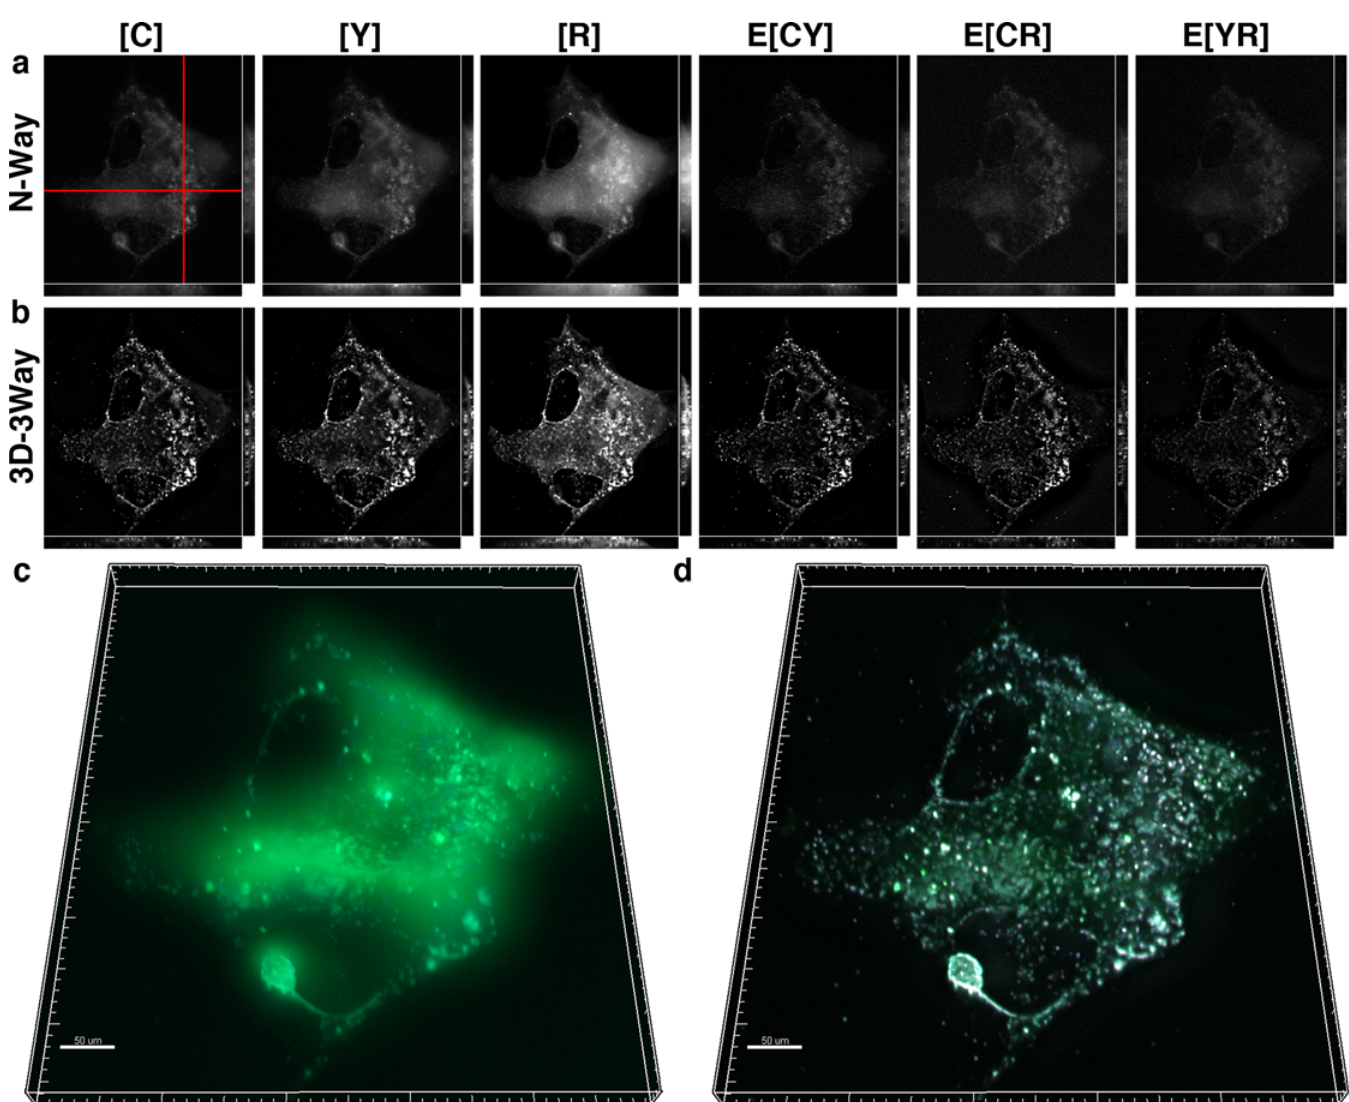
Fig 5. 3D-3Way FRET provides improved estimates for the concentration and localization of HIV-Gag oligomerization in fixed cells. Cos7 cells expressing CFP-Gag, YFP-Gag, and RFP-Gag were fixed and imaged 30 hrs post transfection. The oligomerization of Gag into punctate structures can be seen by direct application of N-Way FRET (a). Following 20 iterations of 3D-3Way FRET (b) the FRET complexes are largely restricted to the puncta and the axial resolution is greatly improved. 3D composite rendering of [C] (cyan) [Y] (green) and E[CY] (magenta) shown following N-Way unmixing (c) and following 3D-3Way reconstruction (d). The reconstructed image highlights the improved axial